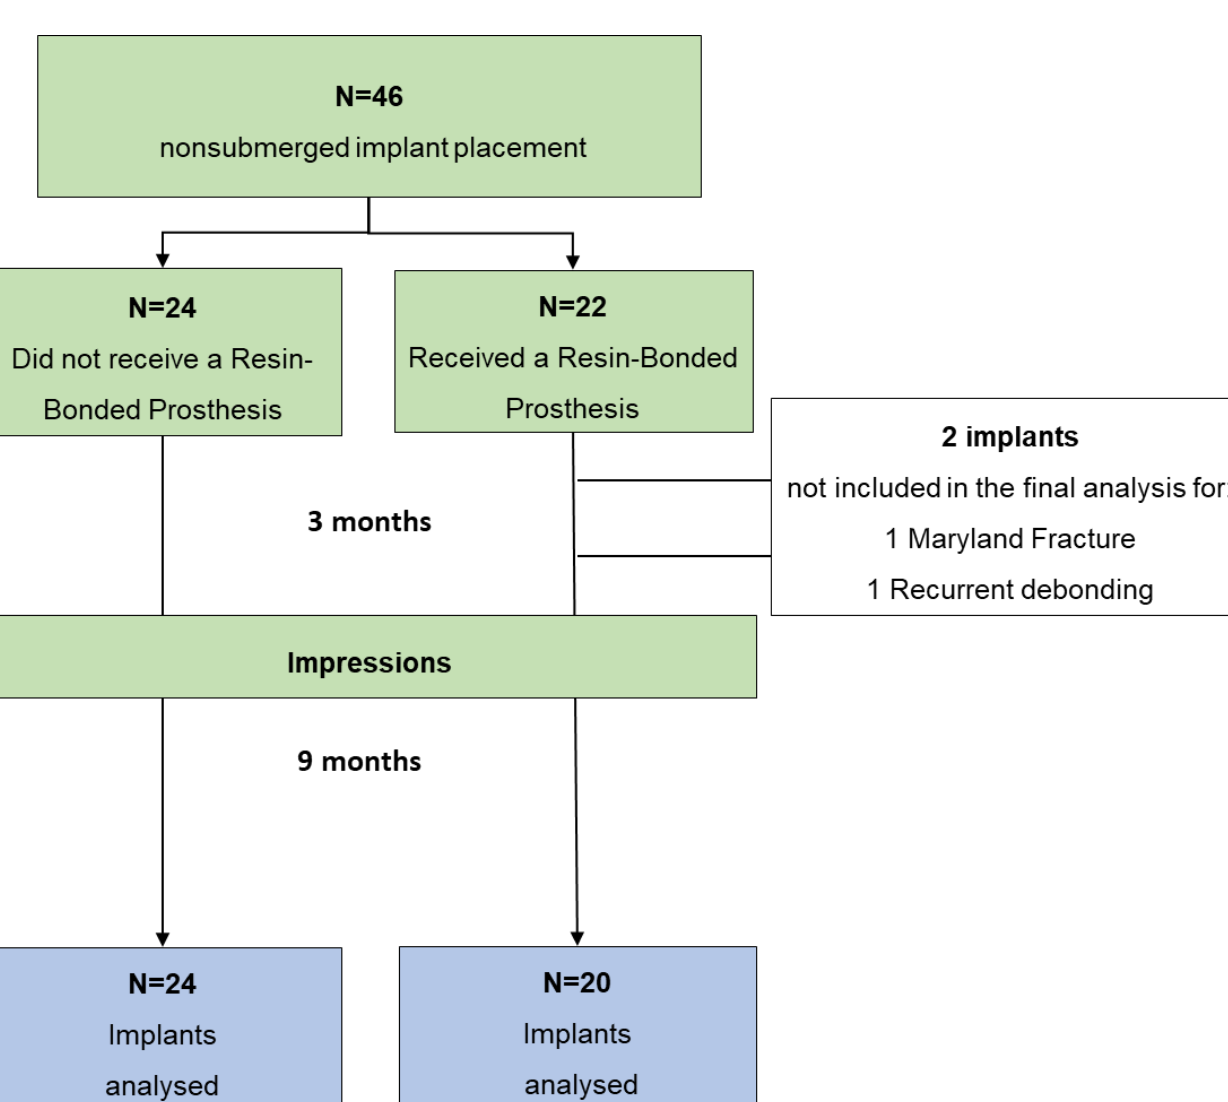
Figure 3. Flowchart of the study and random allocation of